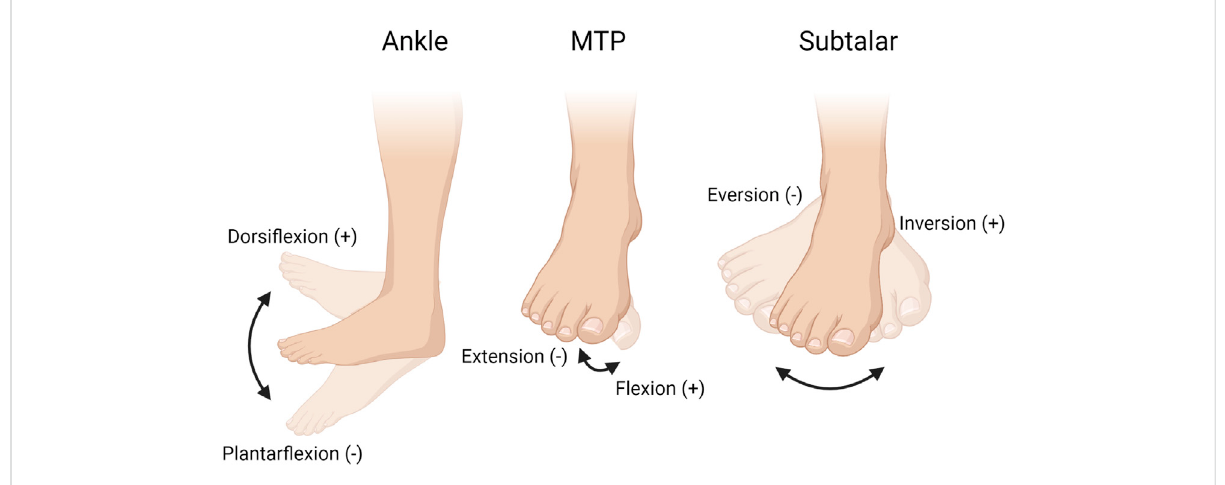
FIGURE 2 The three joints analyzed during the heel raises exercise: the ankle joint (dorsi fl exion/plantar fl exion), the metatarsophalangeal (MTP) joint ( fl exion/extension), and the subtalar joint (inversion/eversion). Figure created with